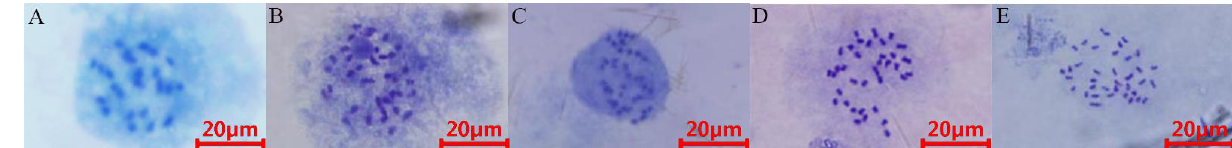
Figure 2. Map of average genomic C-values of jujube germplasm in the middle Yellow River basin by sub-region. AGS: Average genomic C-value. The points represent the geographical coordinates of each sub-region of jujube germplasm.